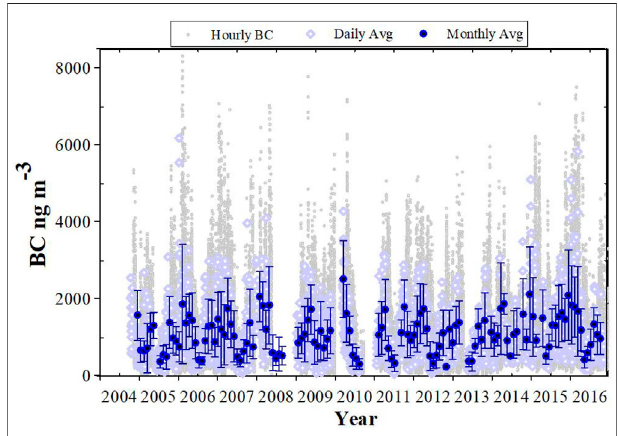
FIGURE 3 | Long-term trend in the observed surface BC mass concentration from December 2004 to December 2016 at Nainital. Here, the temporal variations in the hourly (gray), daily (light blue), and monthly ( fi lled circle in blue) average BC are shown.